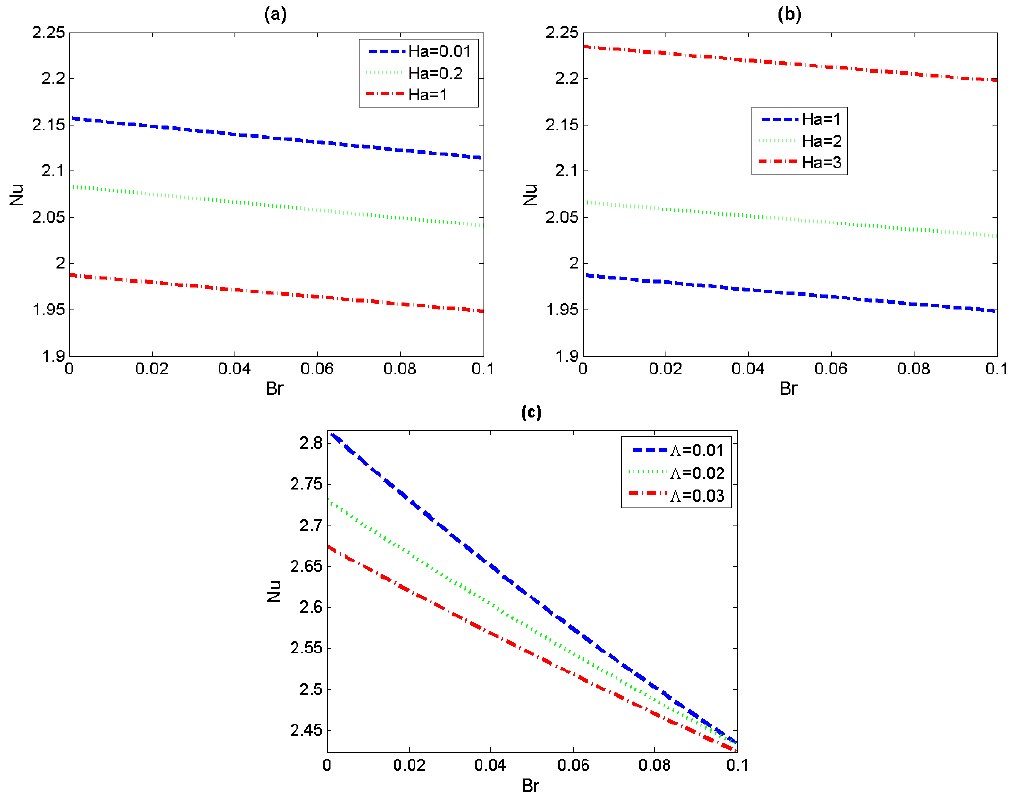
Figure 7. Variations of Nu versus Br with Ha and Λ ( S = 1, Ω = 0), ( a , b ) Λ = 0.5; ( c ) Ha = 3.